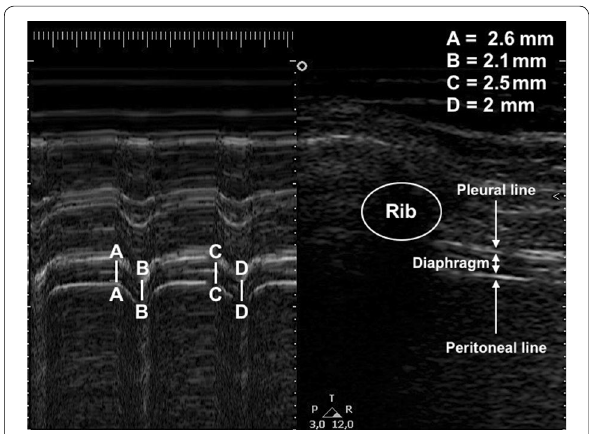
Fig. 5 Diaphragm thickening fraction assessment. a , c End of inspiration thickness; b , d End of expiration thickness